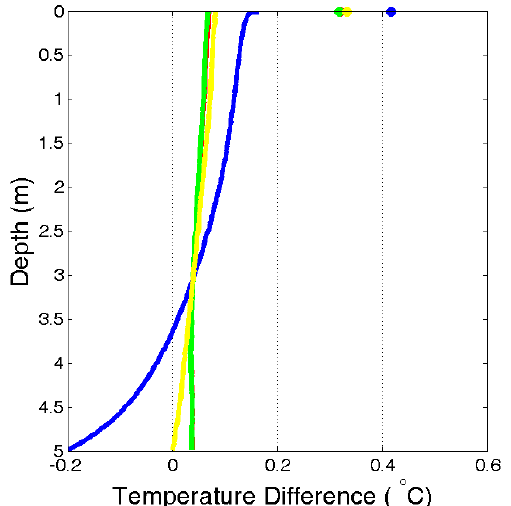
Fig. 6. GL03 data set: differences between the modelled and in situ Fig. 6 : GL03 dataset: differences between the modelled and in-situ measurements for the Base measurements for the Base (blue), Blend (yellow), EWB (green), (blue), Blend (yellow), EWB (green), EST (red) and BST (cyan) models. The surface points EST (red) and BST (cyan) models. The surface points are the dif- are the differences between modelled and M-AERI skin temperatures. ferences between modelled and M-AERI skin temperatures.